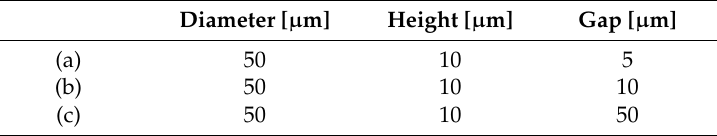
Figure 1. Images of the film-stack reaction field. ( a ) Top-view image. ( b ) Side-view image. The number of stacked film in a film-stack reaction field is five. Two metal pins fix five films and magnetic sheet. The outside diameter and central-hole diameter of the punched film are 5.0 and 2.0 mm, respectively. Table 1. Structural dimensions of the micropillar arrays.